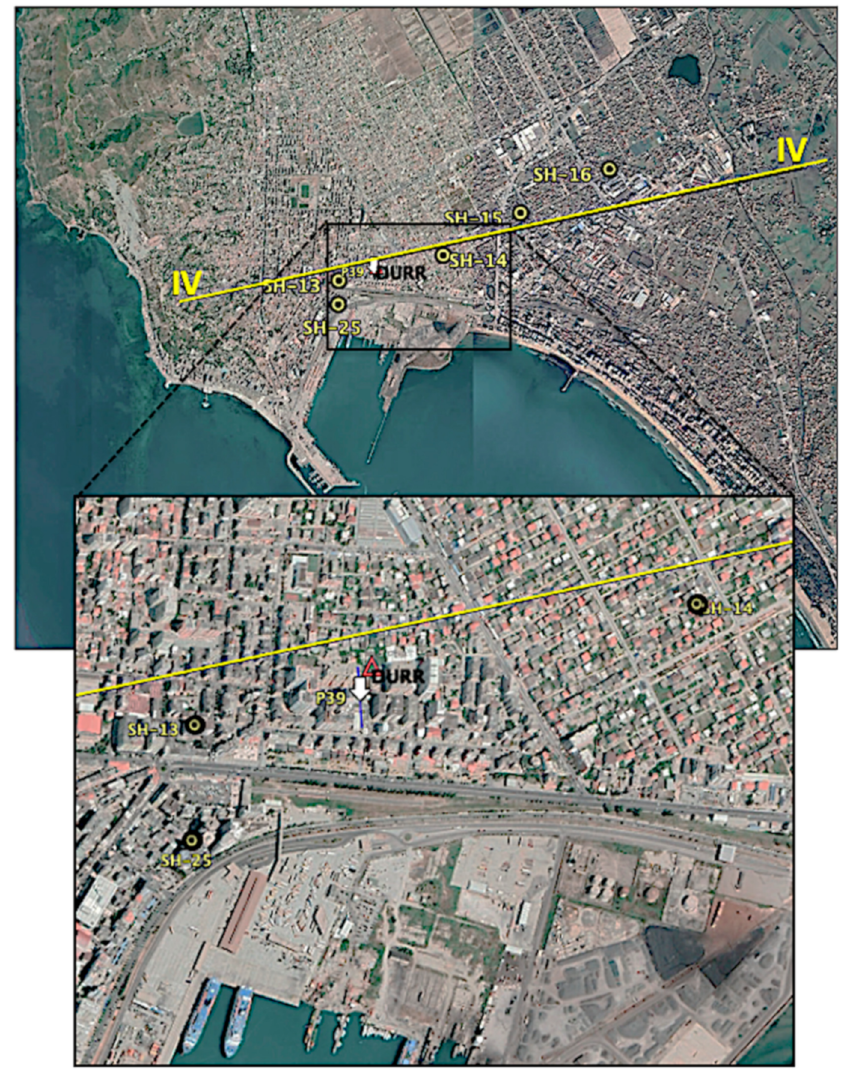
Figure 7. Location of the cross section IV-IV, 6.0 km long ( top part ); The position of DURR station (red triangle) and several boreholes (SH-xx) are also presented ( bottom part ). The white arrow indicates the MASW-Vs measurement profile-P39 carried out close to the DURR accelerometric